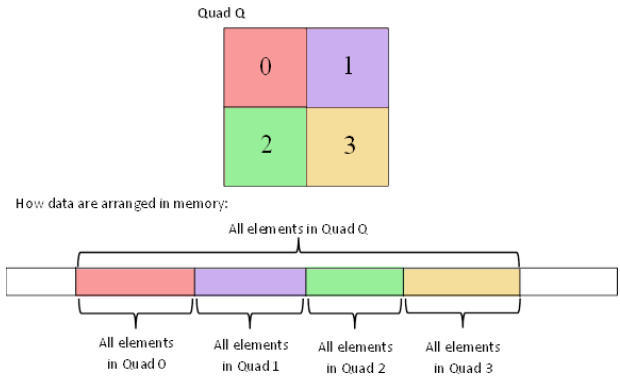
Figure 6. Illustration of how to save the values of an “Integral Quad Tree” into the 1D-array, in order to preserve the condition of “Integral Trees”.